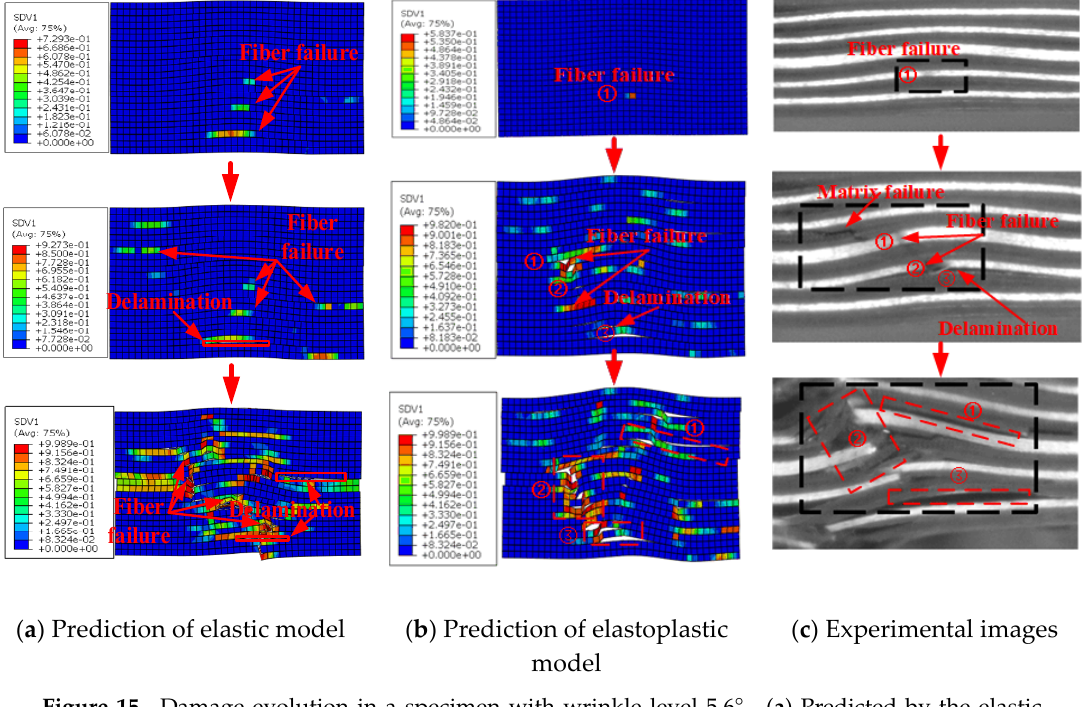
Figure 15. Damage evolution in a specimen with wrinkle level 5.6°. ( a ) Predicted by the elastic model, ( b ) predicted by the elastoplastic model, and ( c ) from high-speed camera images of the damage sequence in [10].